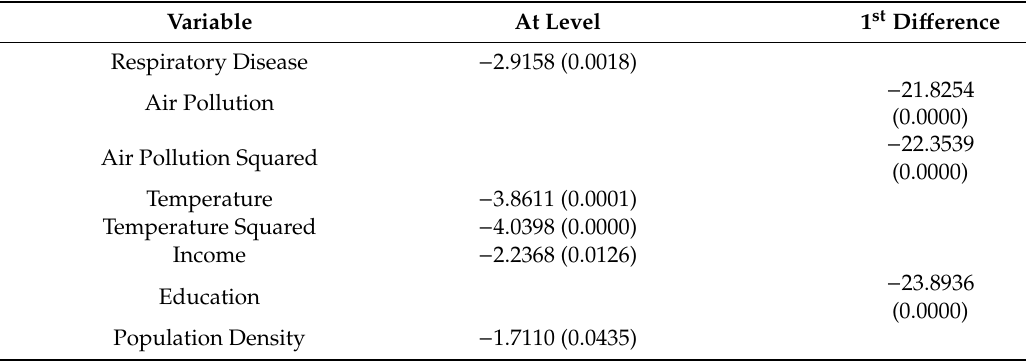
Table 2. Levin –Lin–Chu and Fisher-type test